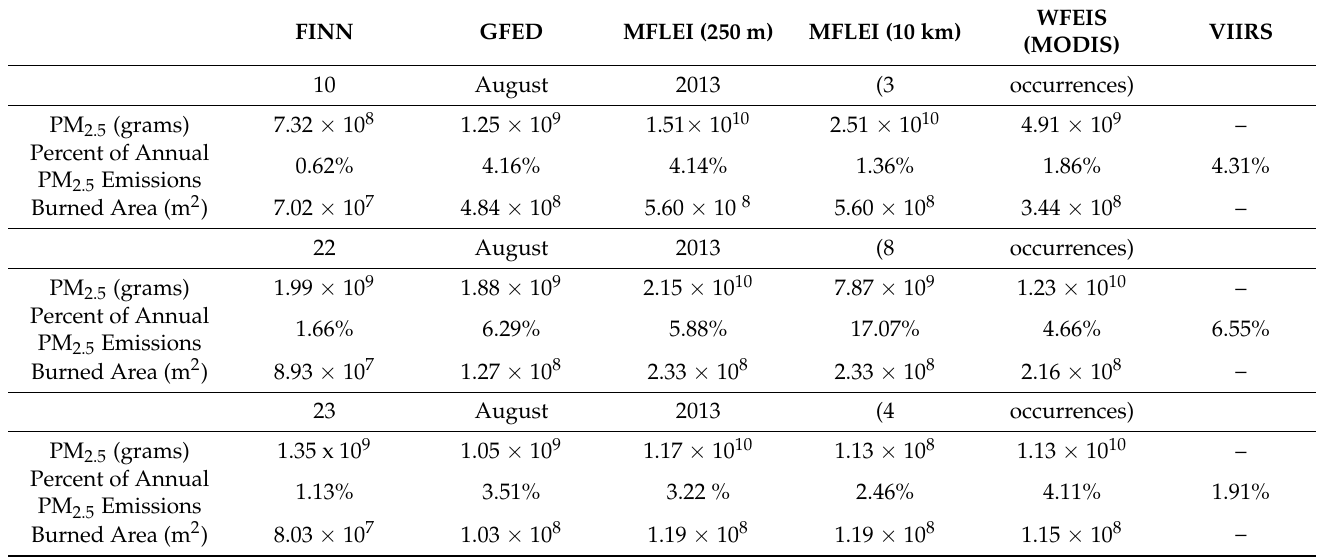
Table 4. Frequent influential points from each model. These dates correspond to the points found most frequently in the influential points analysis. Even on the same individual days that influenced the models, the inventories show vastly different emissions and burned areas each day. The percentage of annual PM 2.5 emissions emitted on that day is presented for all inventories, and the percentage of annual FRP emitted that day per VIIRS data is also provided for